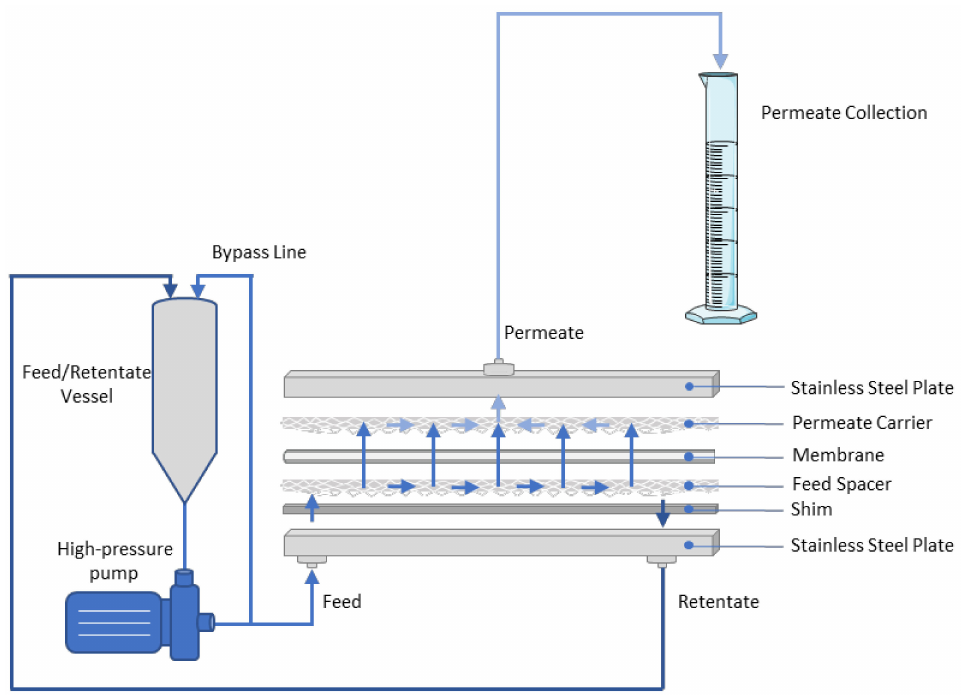
Table 1. The loading parts in the flat-sheet membrane module are shown in Figure 1.